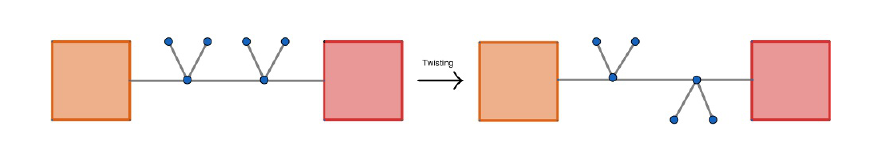
Figure 12 . A quartic graph before and after